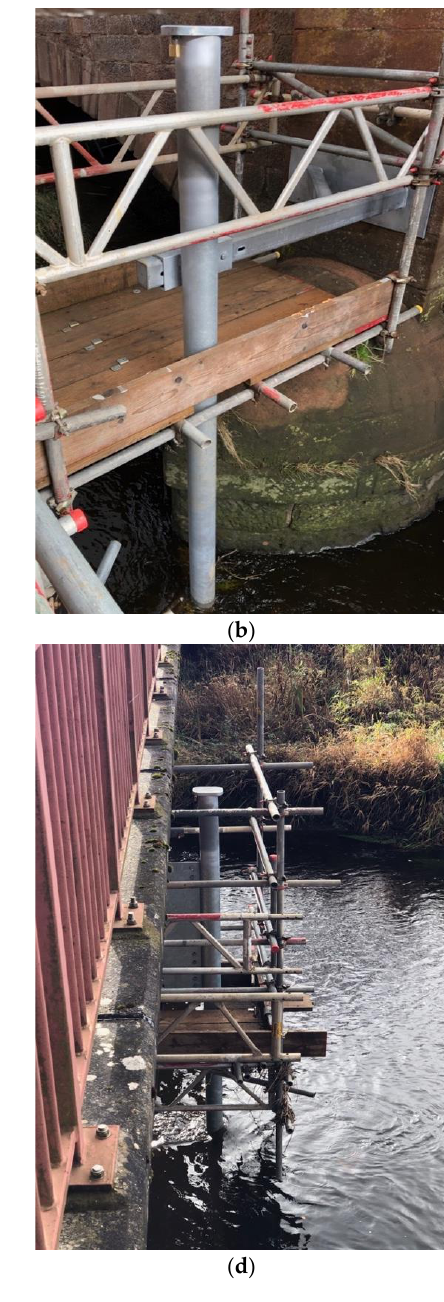
Figure 16. ( a ) and ( b ) Probe P1; ( c ) and ( d ) Probe P2.